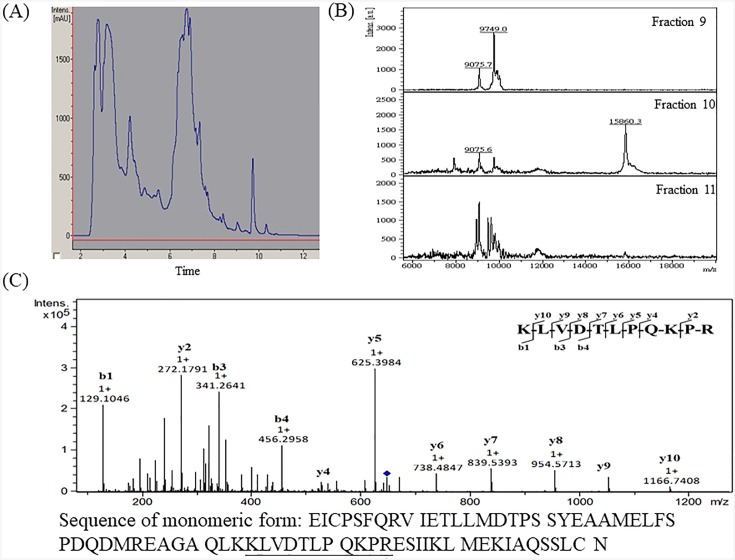
(A) Representative LC-UV chromatogram of urinary proteins from a DM-NP subject. The eluent was collected at 60-s intervals. (B) MALDI-TOF MS analysis of LC subfractions 9, 10, and 11. The marker peak of m/z 15860 was found in fraction 10. (C) Identification of the corresponding peptide of the m/z 647.91 peak by nanoLC-MS/MS. The sequence of CC16 was shown and the identified peptide sequence was underlined.